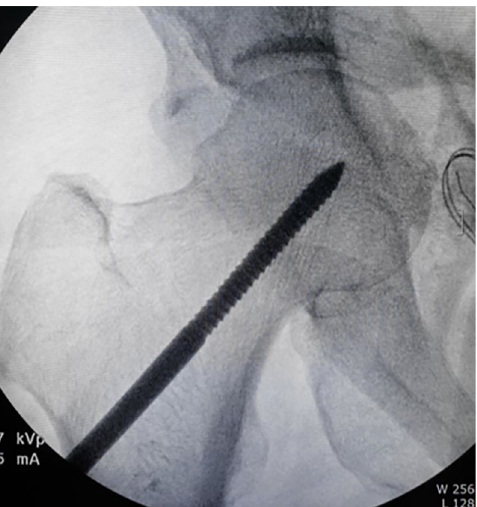
Figure 2. A fluoroscopic image of the insertion of the Schanz screw into the femoral head on operating side.